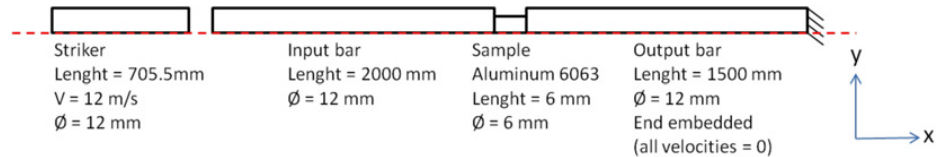
Fig. 3. Initial conditions employed for numerical simulation with copper bars and aluminum sample.